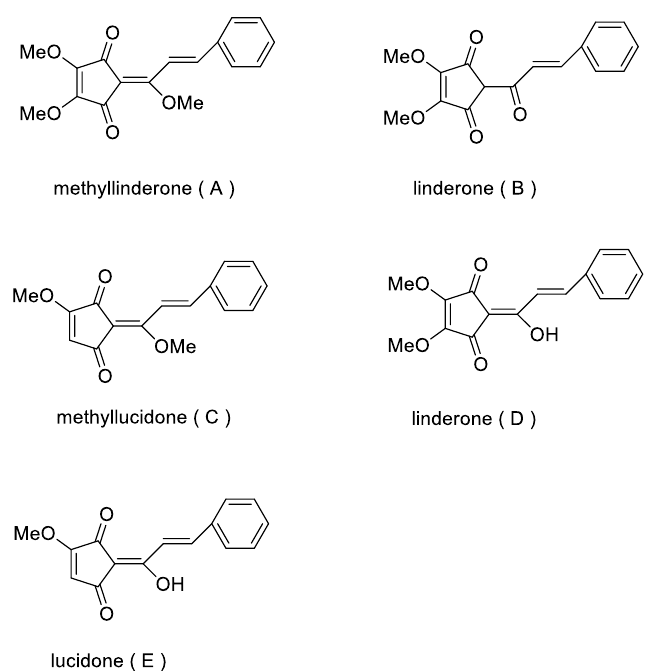
Figure 1. Chemical structures of methyllinderone ( A ), linderone ( B ), methyllucidone ( C ), linderone ( D ), lucidone ( E ).